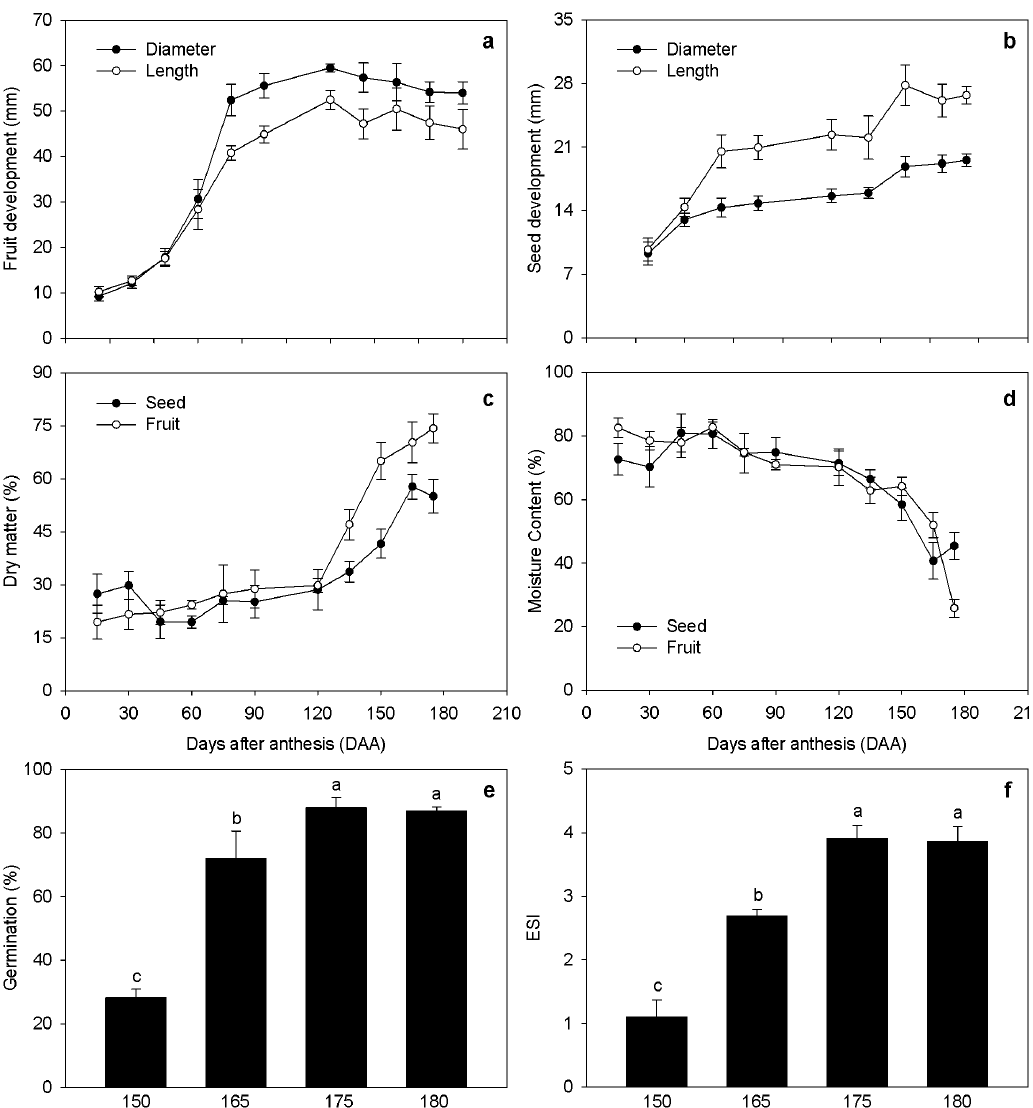
Figure 1 - Growth curve for fruits ( a ) and seeds ( b ), of Hevea brasiliensis L., seeds harvested at 150, 165, 175 and collected at 180 DAA. For fruits n = 30, seeds n = 90 ± standard error. Dry matter and moisture content of fruits ( c ) and seeds ( d ), n = 5 ± standard error; Germination/emergence ( e ) and emergency speed index (ESI) ( f ), n = 5. Means followed by the same letter do not differ by Tukey’s test at a 5%